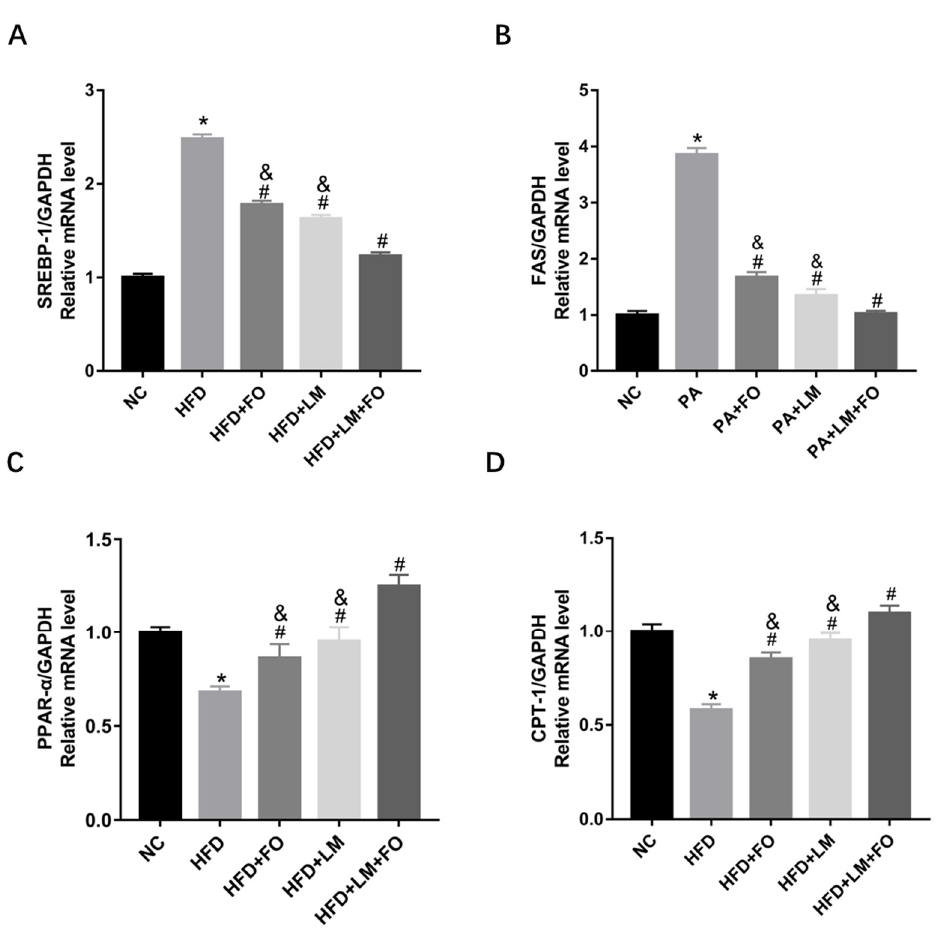
Figure 4. The effects of FO and LM on lipid metabolism in HFD mice. Real-time PCR was employed to determine mRNA expression of adipogenesis genes in the liver, including ( A ) SREBP-1, ( B ) FAS, ( C ) PPAR α , and ( D ) CPT-1. Data are presented as means ± SD ( n = 3). * p < 0.05 vs. NC; # p < 0.05 vs. HFD; & p < 0.05 vs. LM + FO.